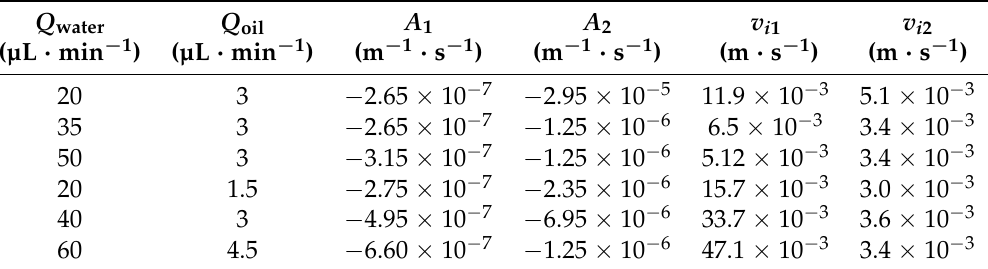
Table 1. Fitting parameters used in Equations (7) and (8).